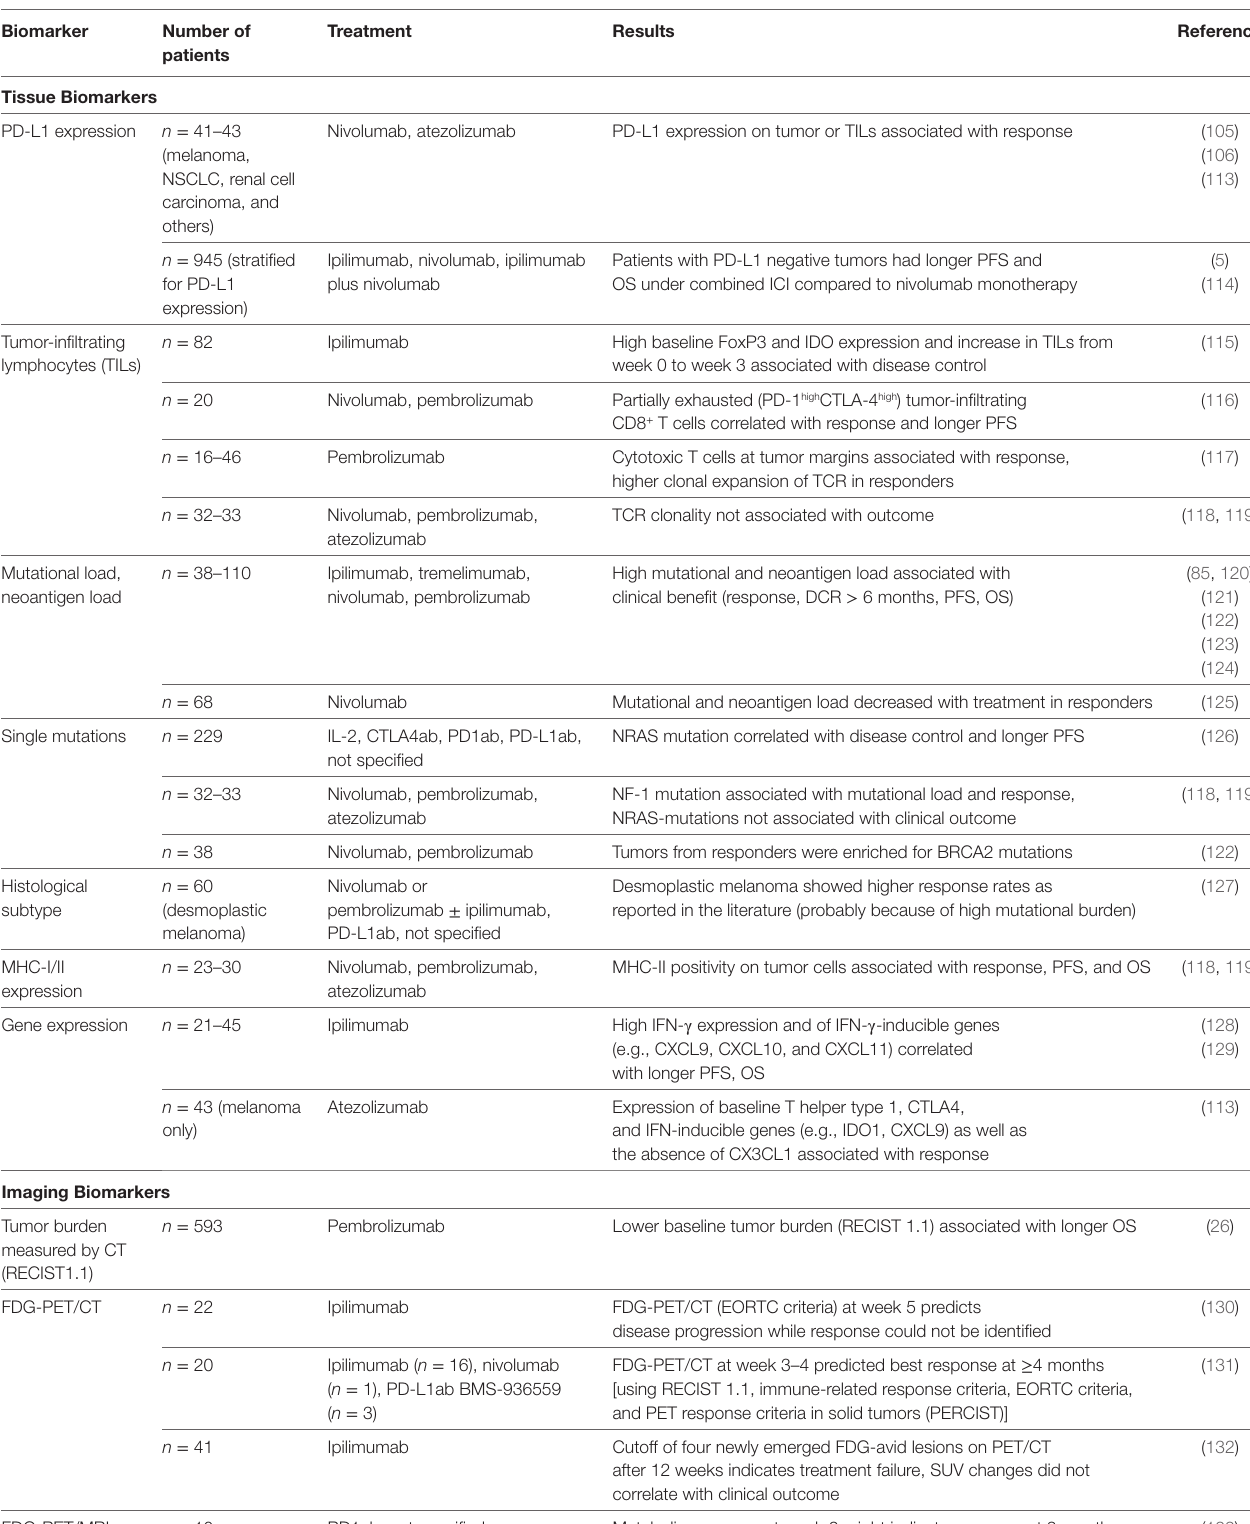
TABLe 2 | Tissue and imaging biomarkers for clinical outcome under checkpoint blockage for metastatic melanoma